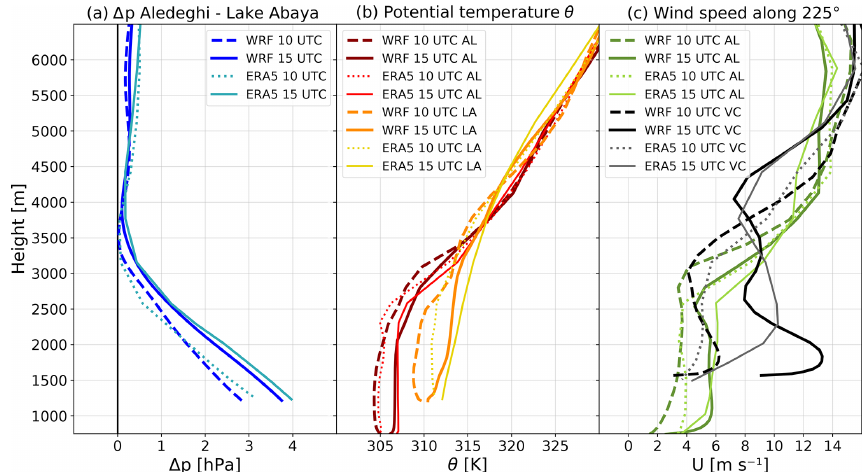
Figure 4. Vertical profiles at two model grid points at Aledeghi (AL) and Lake Abaya (LA; Fig. 1b), respectively, for both the WRF simulation and the ERA5 reanalysis. (a) Pressure differences (cid:49)p in WRF (dark blue) and in ERA5 (light blue) for 10:00 and 15:00UTC 14 January 2020. (b) Potential temperature θ , indicating the vertical stratification of the atmosphere up- and downstream, for both models at the two times. (c) Wind component in an azimuth direction of 225 ◦ (i.e. along the valley) for Aledeghi and for a model grid point in the along-valley centre (VC; Fig.